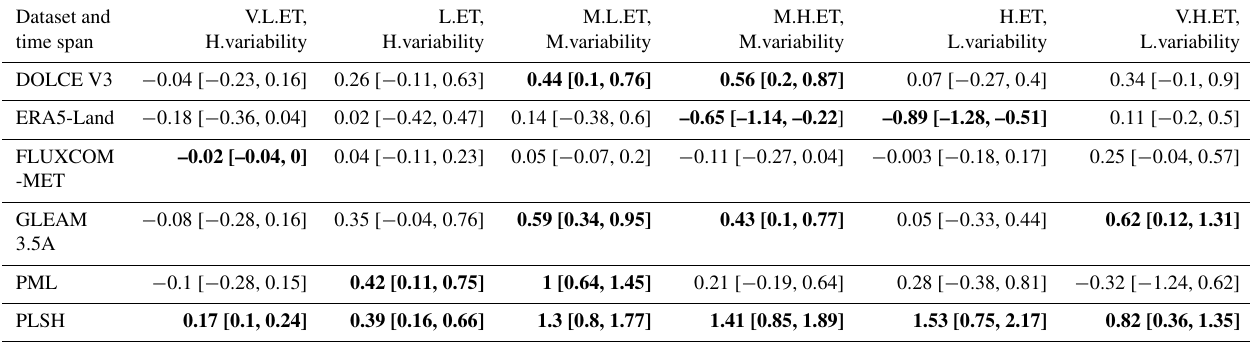
Table 5. Trends in yearly ET total (mmyr − 1 ) spatially averaged across each ET regime calculated for DOLCE V3 and five participating parent datasets available during 1982–2012. The text shows slopes of the trend line and their confidence intervals calculated at the 95% confidence level; bold text indicates that the trend is reliable since the confidence interval is strictly positive or negative. Dataset